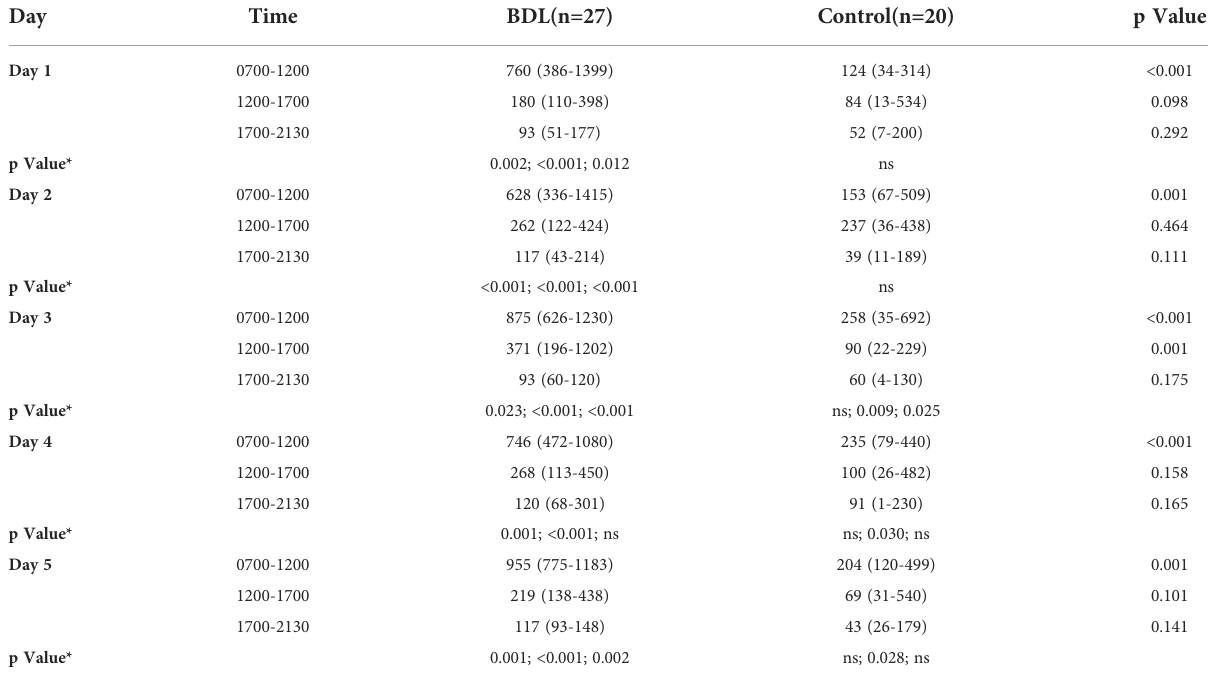
TABLE 3 The dose of the effective circadian irradiation (Hec) of the patients in the group with a biodynamic lighting system (BDL) and the control group during the inpatient stay.